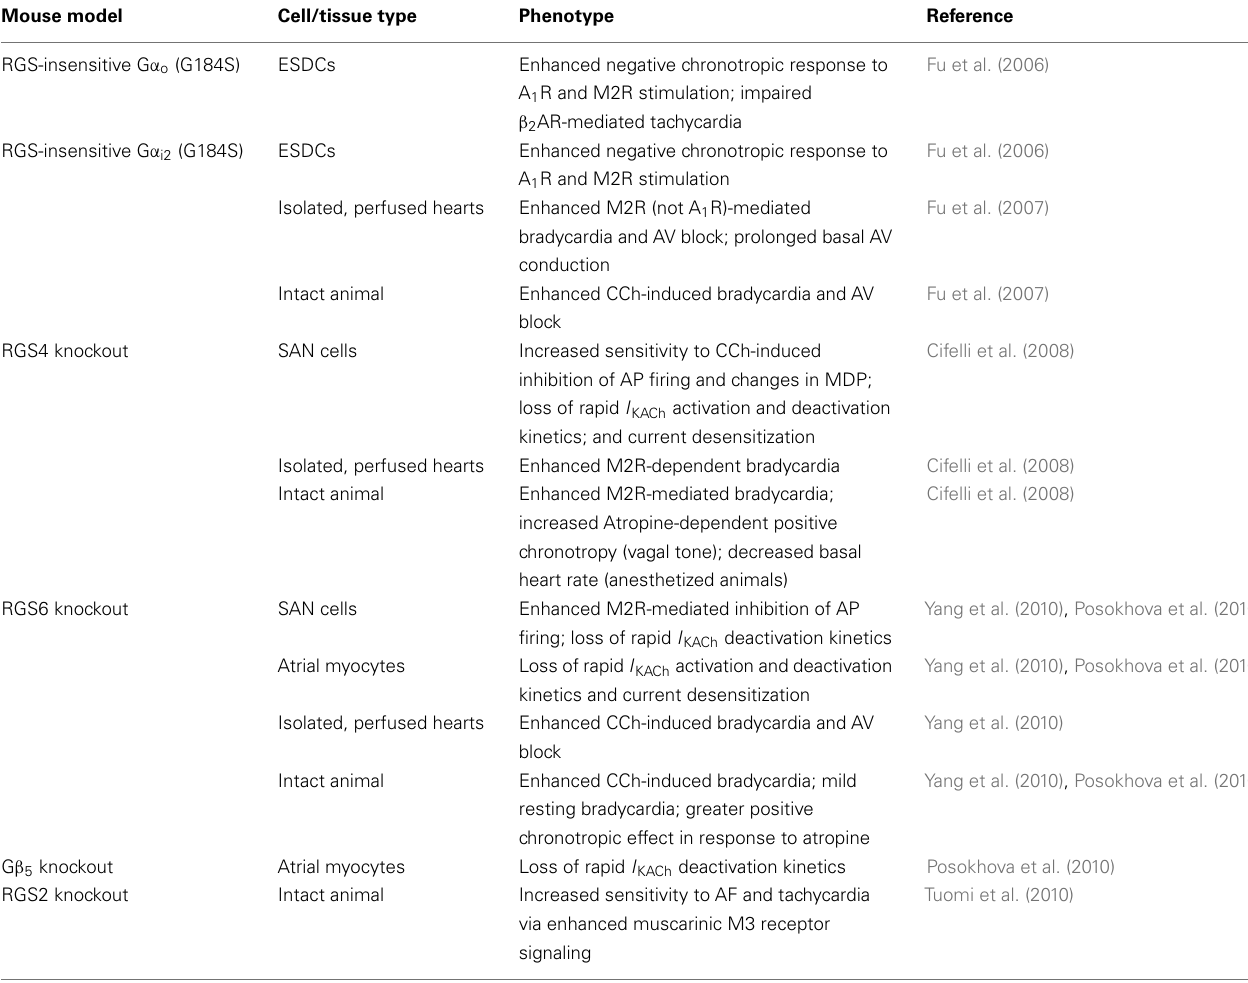
Table 2 | Mouse models implicating RGS proteins as key modulators of cardiac automaticity and their associated